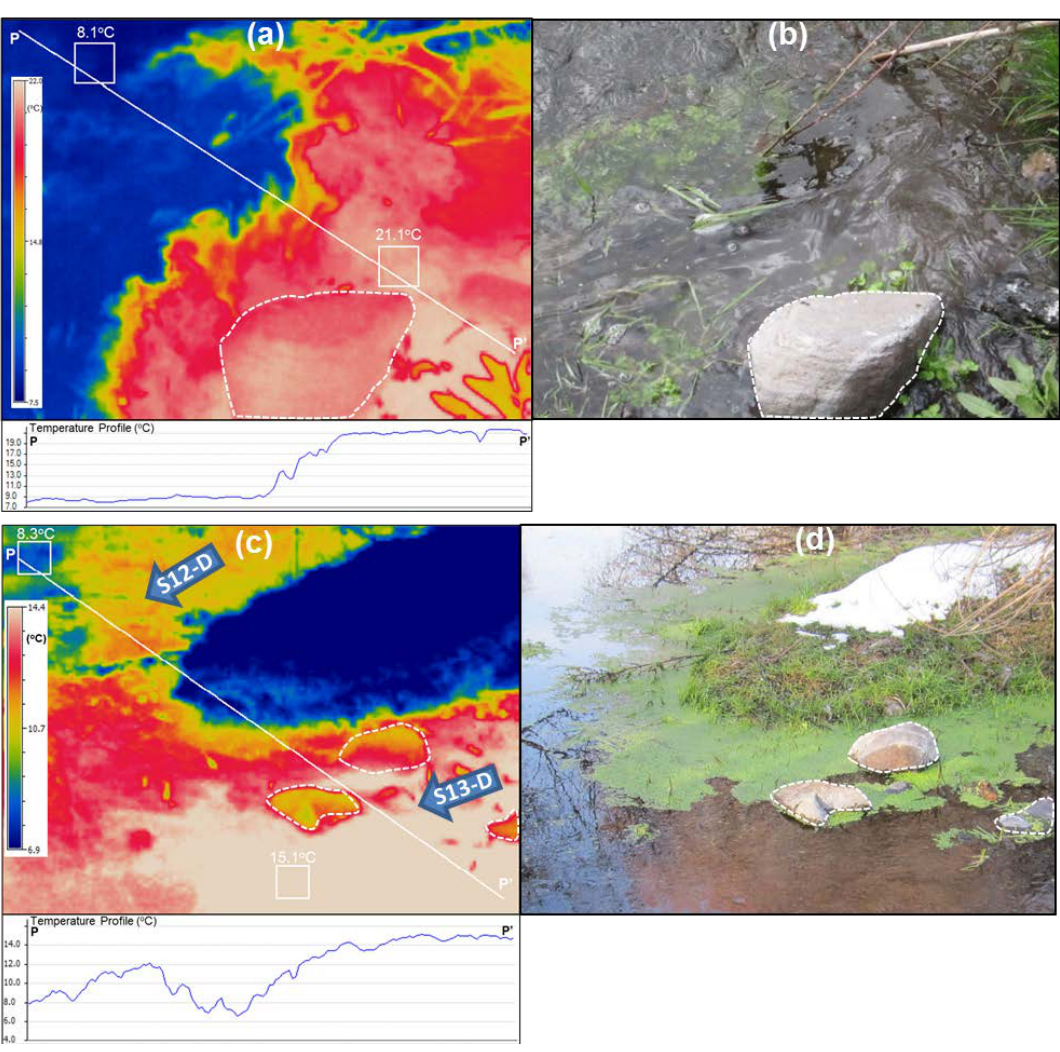
Figure 4. ( a ) A sample TIR imagery indicating groundwater seepage (warmer) close to S10-P location; ( b ) visible imagery of the same location; ( c , d ) same as ( a , b ) but for a location where two stream branches with different surface water skin temperatures merge. Note: In TIR imagery, the diagonal line is the temperature profile line and each rectangle denote the representative averaging areas with average temperature indicated on top.